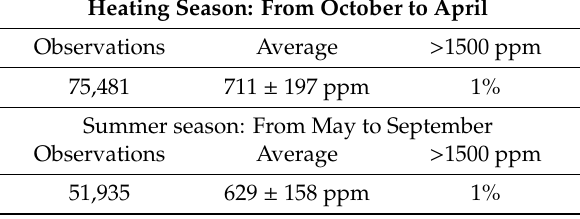
Table 8. Average CO 2 concentration and the proportion of observations that exceeded the action limit after